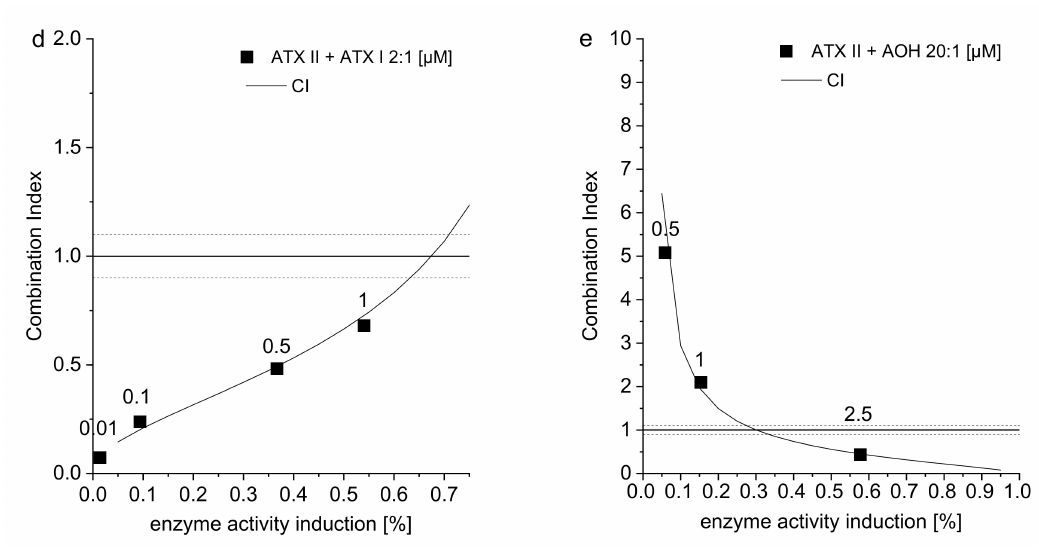
Figure 3. EROD assays with binary mixtures of AOH, ATX-I, and ATX-II. Bar diagrams show EROD enzyme activity measurements (pmol resorufin / mg protein*min) expressed as means + SD of at least 3 individual experiments in relation to the solvent control (1% DMSO). ( a ) ATX-II and ATX-I alone and in combination (ratio 2:1), ( b ) ATX-II and AOH (combinatory ratio 20:1) and ( c ) ATX-I and AOH (combinatory ratio 10:1). In order to approach the ratios resembling the extract, some concentrations used for the combinations diverge from the amounts applied singularly. “*” ( p < 0.05), “**” ( p < 0.01) and “***” ( p < 0.001) indicate significant di ff erences of incubation conditions against the NOEL. Significant di ff erences were calculated applying a one-way ANOVA followed by Bonferroni post-hoc testing. “#” and “$” represent significant di ff erences of combinations compared to the corresponding first and second single substance within the graph, respectively. ( d , e ) CI plots highlight combination index values at measured concentrations. Dotted lines indicate the “nearly additive e ff ect